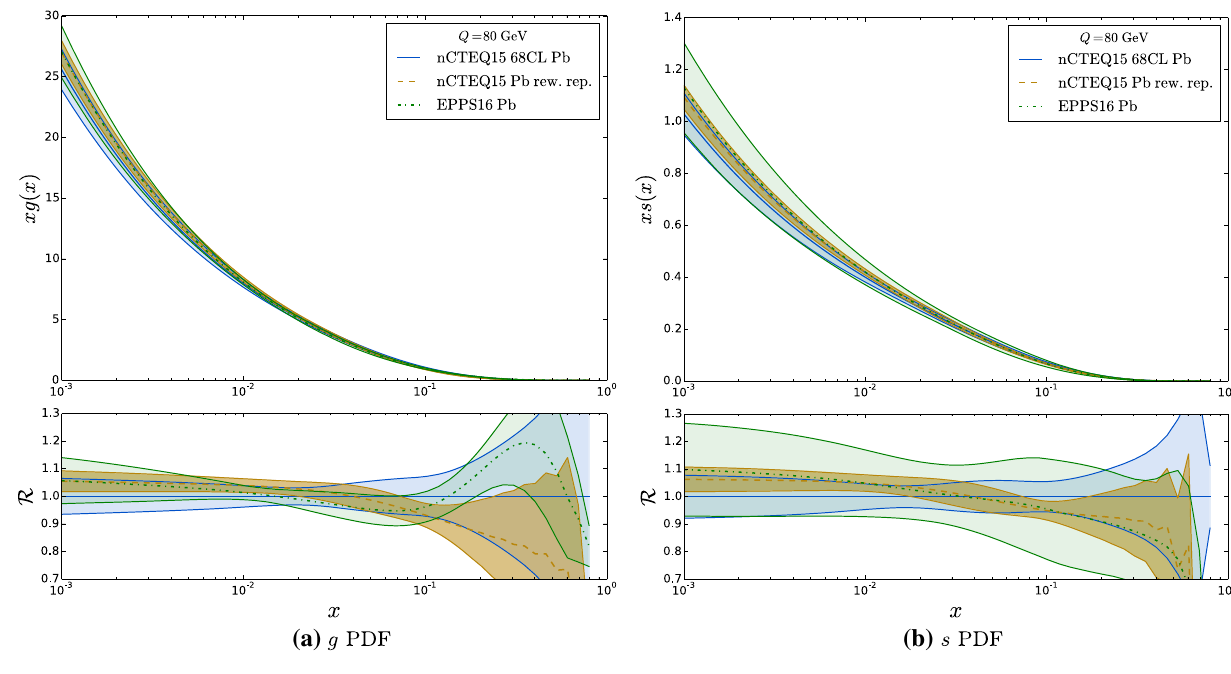
Fig. 31 Continuation of Fig.